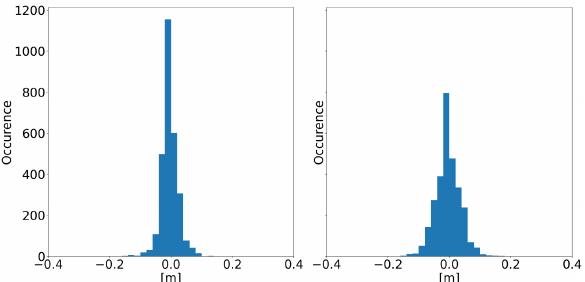
Figure 10. Distribution of the highest consensus sets along the x - and y